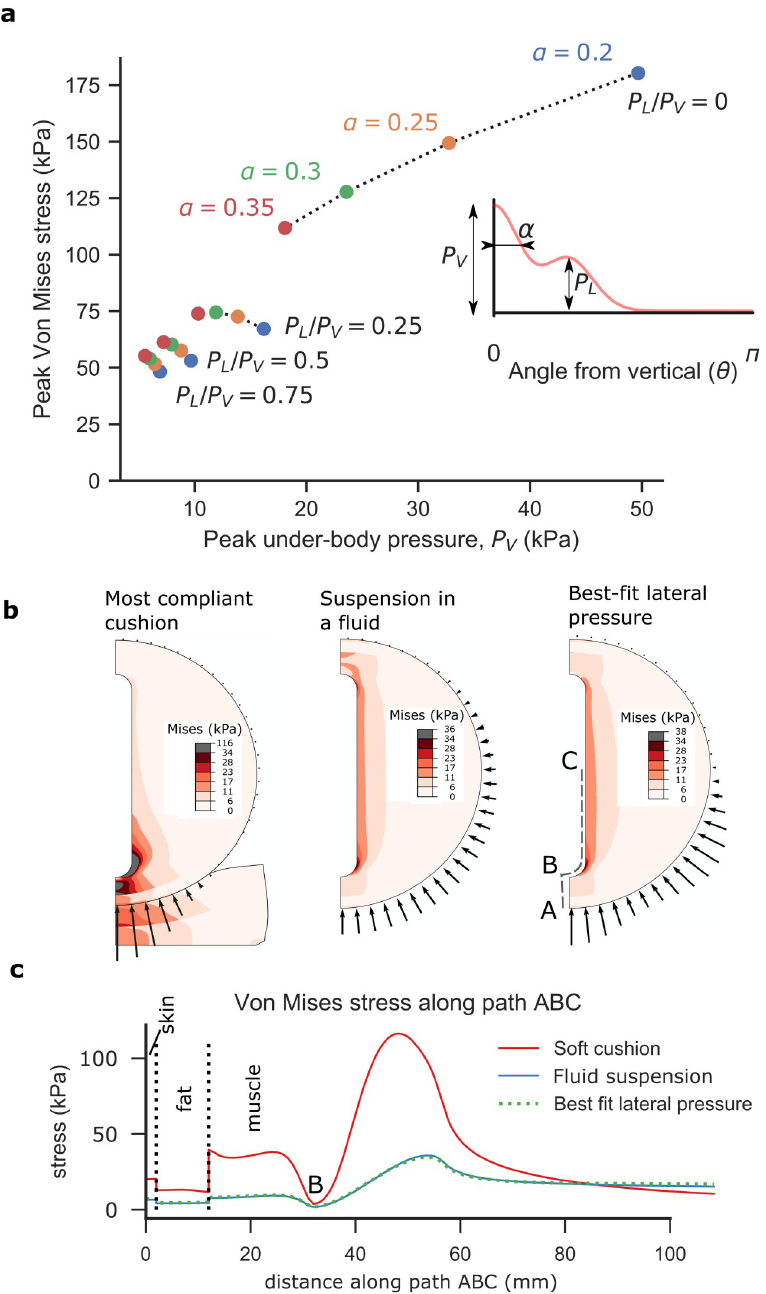
Fig 6. Surface pressure analysis. Redistributing under-body pressure ( P V ) reduces peak von Mises stresses when no lateral pressure is applied (a), but peak stresses remain above 100 kPa. Counter-acting that pressure with a lateral pressure ( P ) reduces peak stresses to a greater extent. When the magnitude and angle of lateral pressure is optimised, L the deep tissue von Mises stresses approach that of suspension in a fluid (b; arrows illustrate pressure intensity). Path plots of von Mises stress show that lateral pressure can induce a similar stress profile at the bony prominence to that when suspended in a fluid